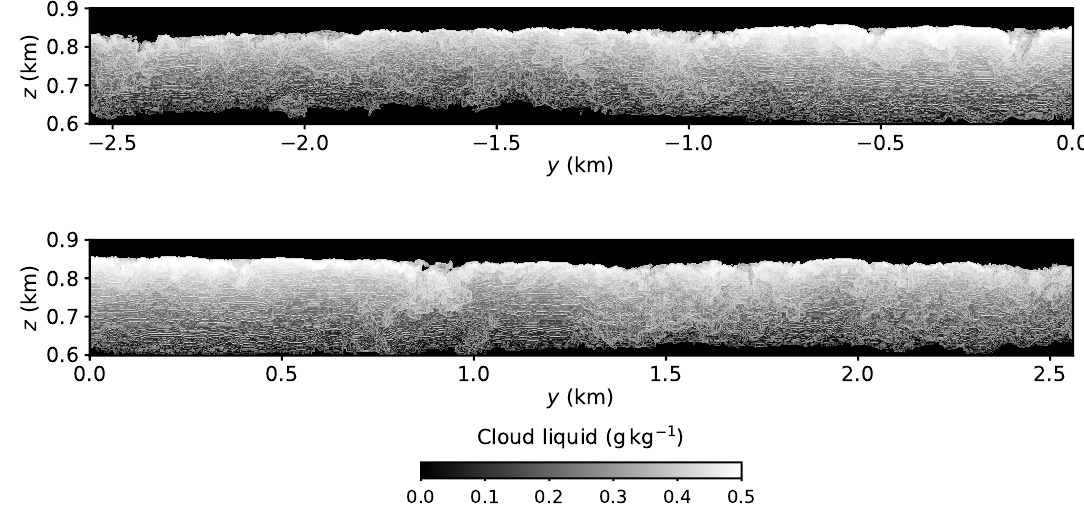
Figure 7. Cloud liquid mixing ratio on a vertical plain at x = − 1 km for Case M1. The elongated domain is partitioned into two panels. Only the cloudy region is shown. The cloud-top slits are absent in Case M1 (c.f., Figure